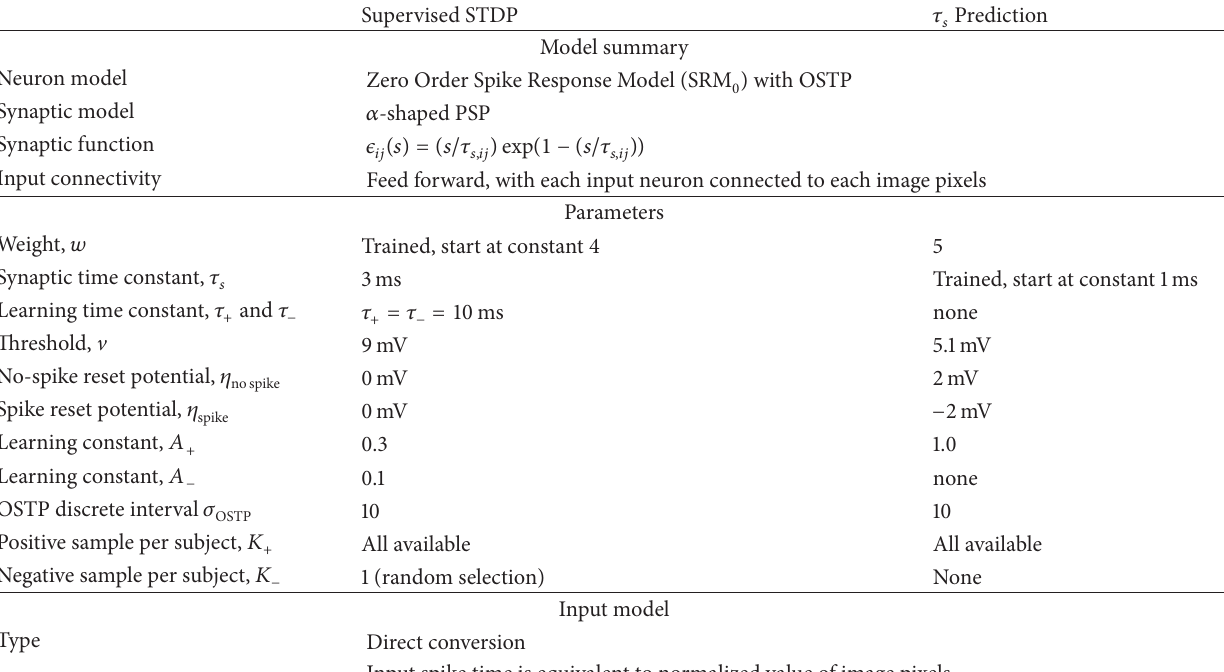
Table 1: Tabular description of experimental setup as suggested in [36].